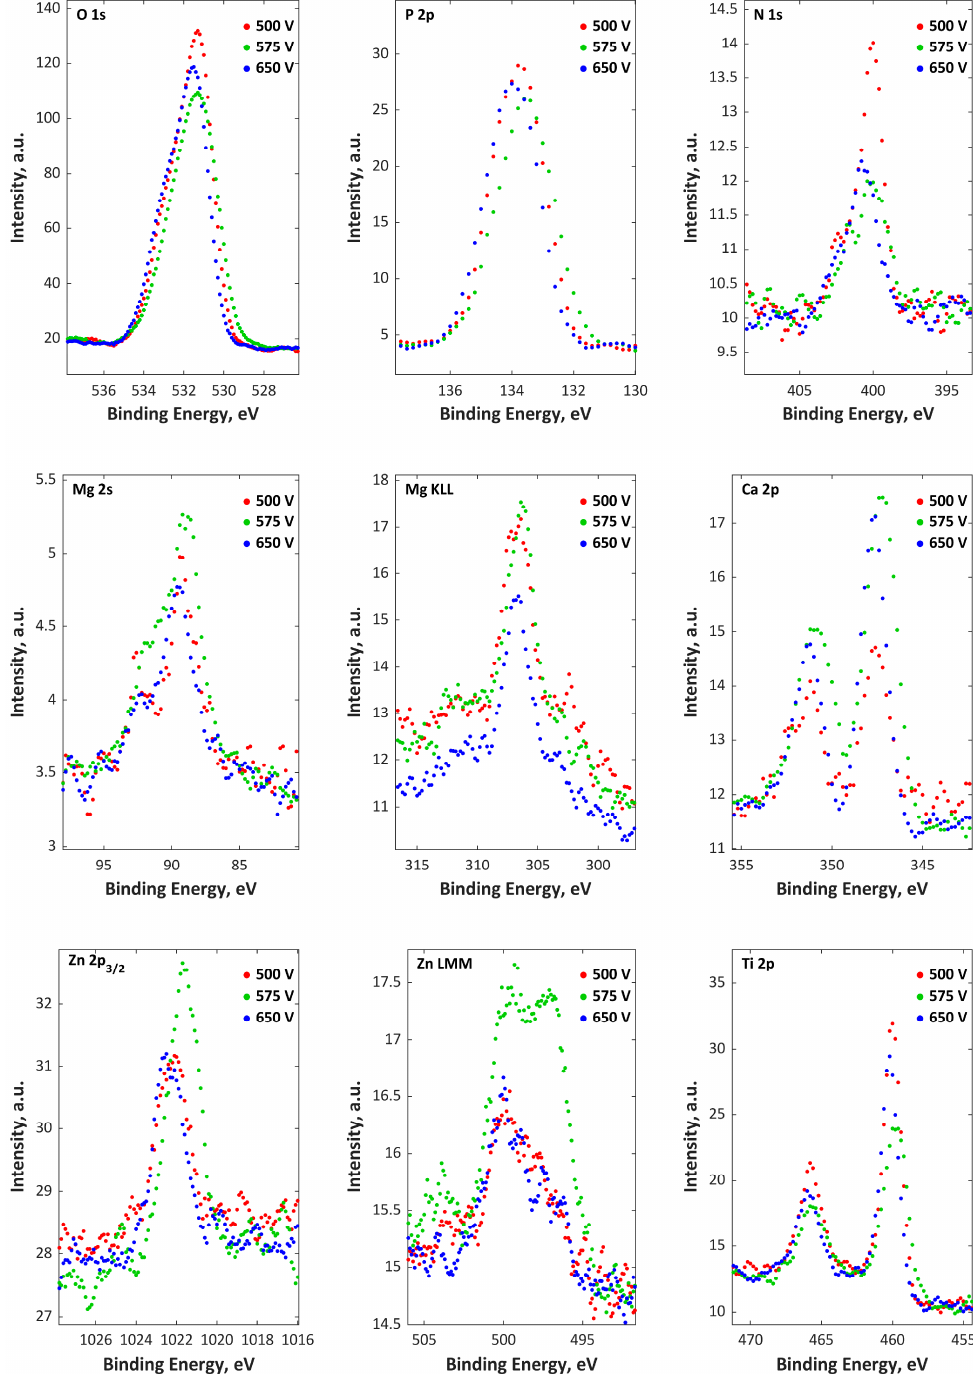
Figure 7. XPS spectra for titanium samples after PEO treatment in Electrolyte 1.